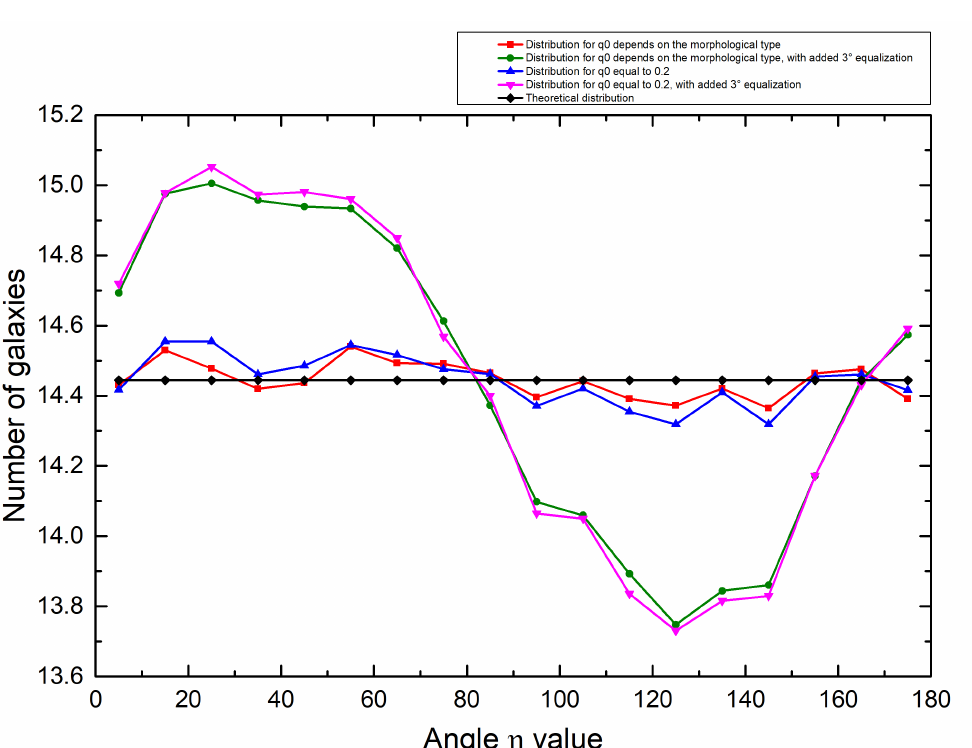
Figure 10. Simulated distributions of the angle η for group